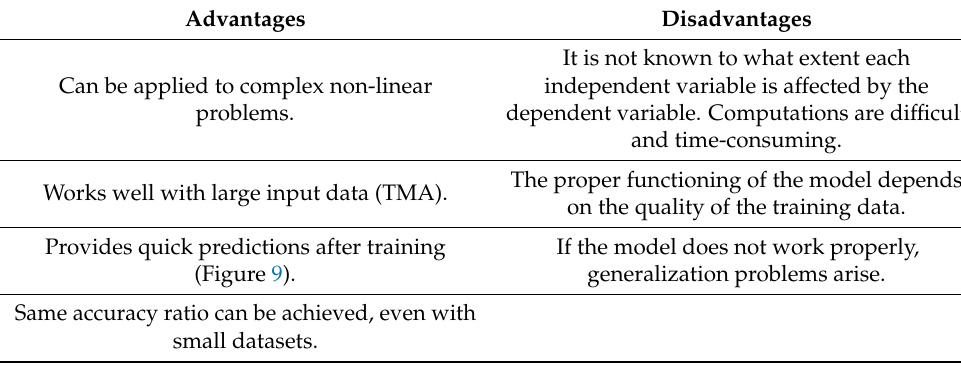
Table 12. Proposed ecological green belt and bow policies for nature-based development.